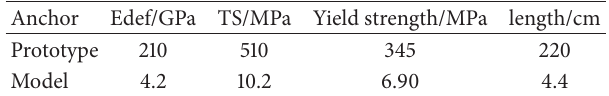
Table 3: Physical-mechanical parameters of prototype and equiva- lent